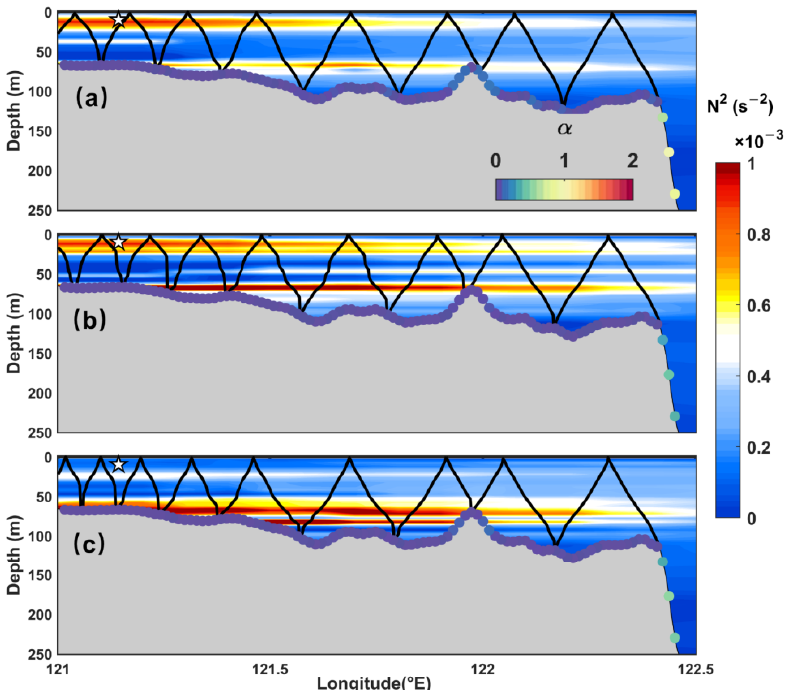
Figure 11. Calculation of the M 2 tidal beam reflections on the continental shelf from the slope area to mooring (white pentagram). The color indicates monthly climatology stratification derived from the WOA18 data. The black solid lines indicate the ray tracks of tidal beams, based on the formula (𝑡𝑎𝑛𝜃 = √(𝜔 2 − 𝑓 2 )/(𝑁 2 − 𝜔 2 ) ). The color dots indicate the bathymetry criticality 𝛼 = 𝛻𝐻 ray tracks are presented in ( a ) June, ( b ) July and ( c ) August.